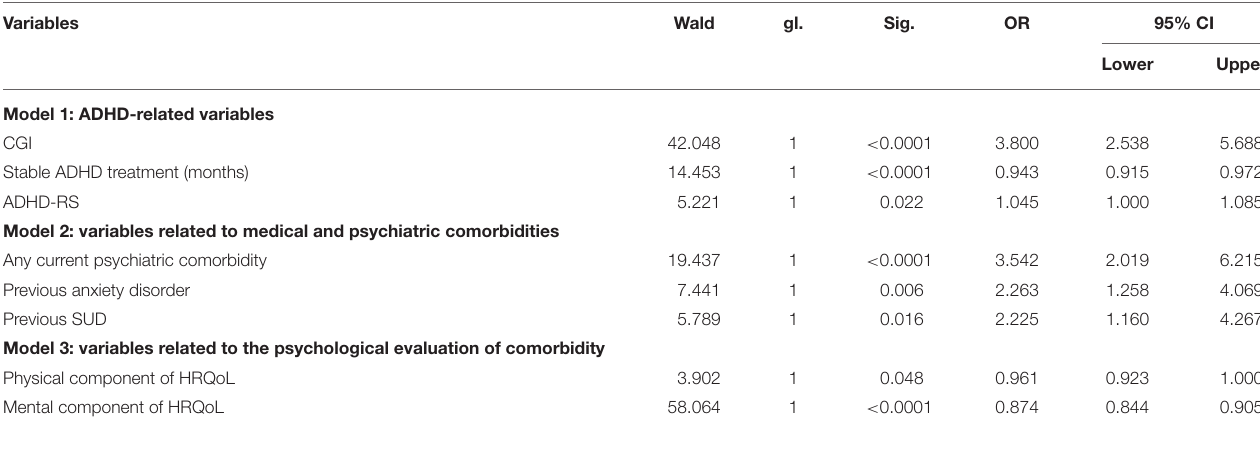
TABLE 5 | Multivariate analysis of variables associated with insomnia disorder. Variables